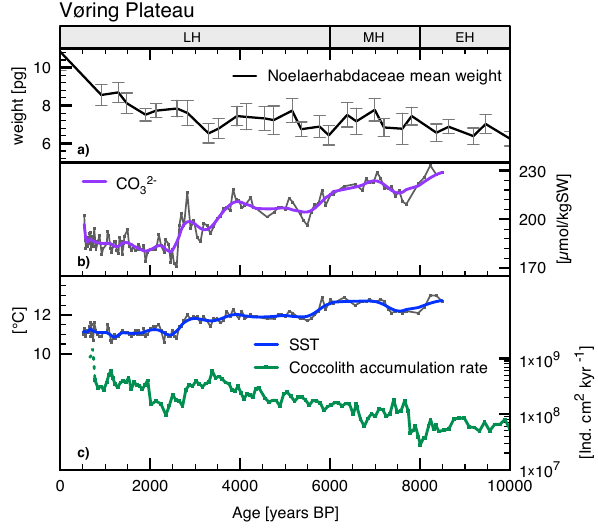
Fig. 11. Vøring Plateau, core MD08-3192. (a) Noelaerhabdaceae mean coccolith weight (black line). Error bars indicate 95% confi- dence intervals of the mean weight. (b) Carbonate ion concentration (purple line) and (c) SST (Calvo et al., 2002; blue line) and coccolith accumulation rate (Giraudeau, unpublished; green line). Bold lines are smoothed (by factor of 4), and grey thin lines represent original